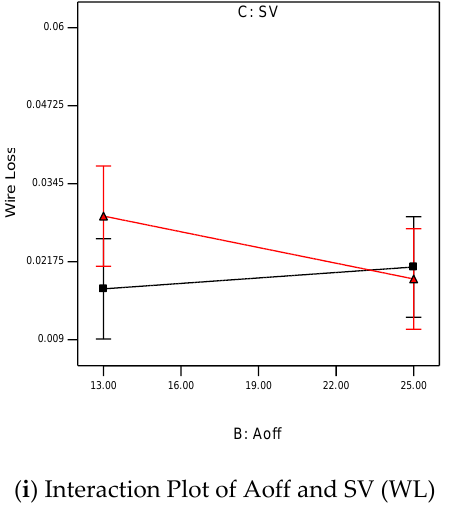
Figure 6. Summary of process parameters with respect to WL and